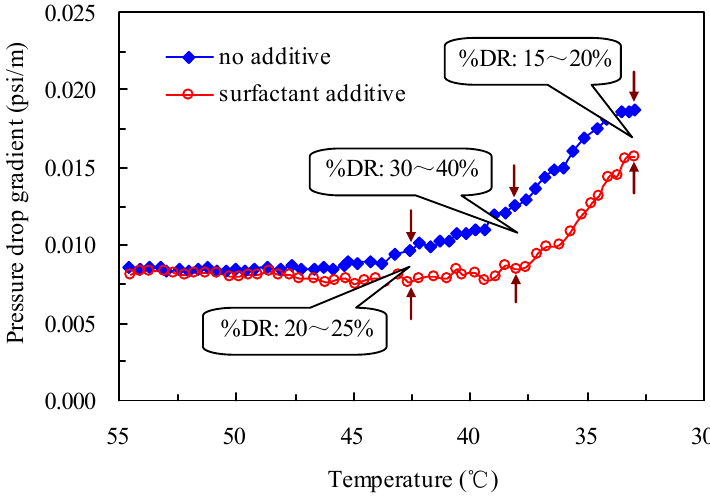
Figure 9. Variation of the pressure drop reduction before and after the drag-reducing surfactant addition (adding 100 mg/L of biobased surfactant).